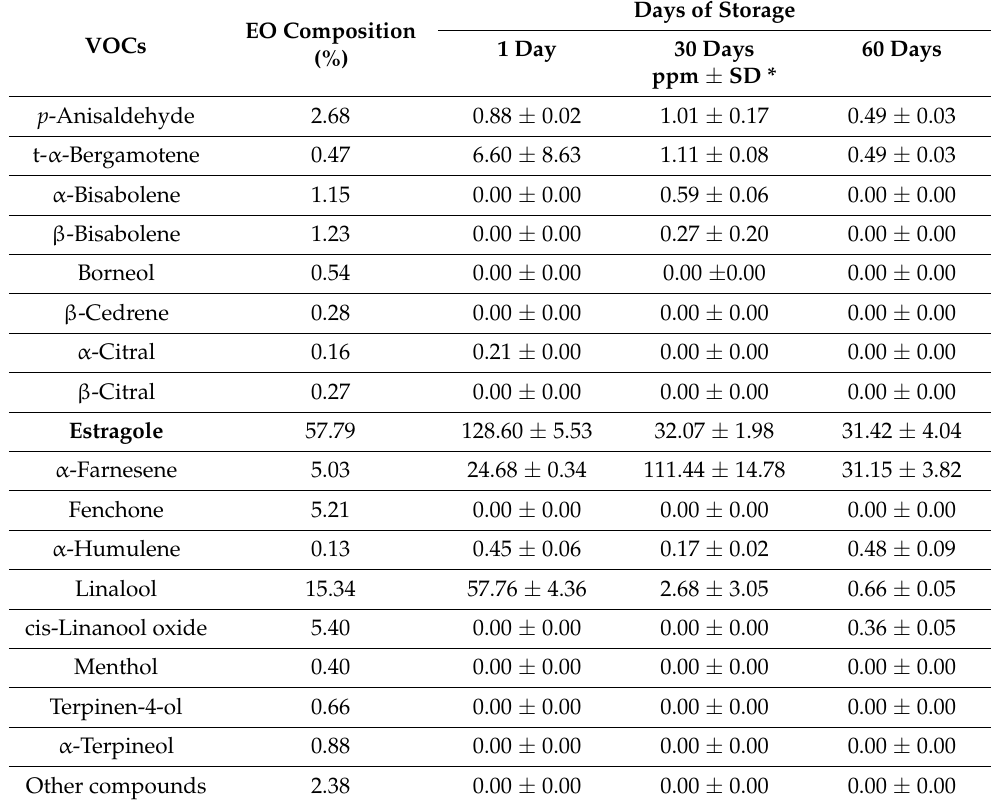
Table 6. Composition of basil essential oil and characterization of the atmosphere of cabinet during the storage trial on apples ‘Opal’ obtained by GC-MS and SPME-GC-MS analysis, respectively. Air in the cabinet was sampled at 1, 30, and 60 days of